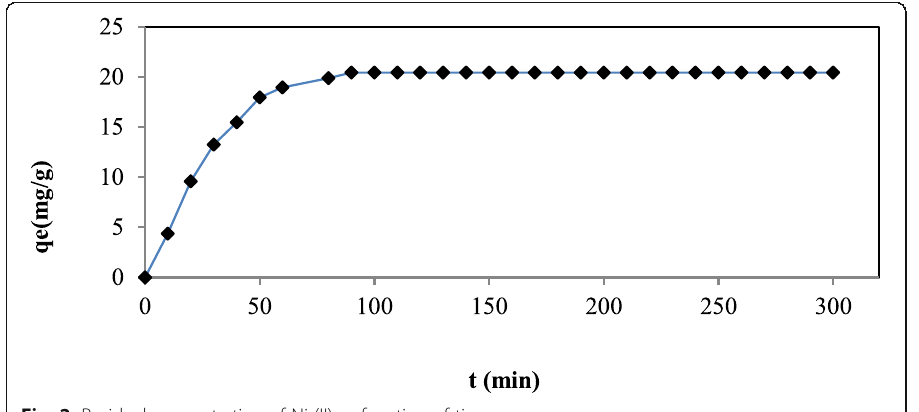
Fig. 2. Residual concentration of Ni (II) as function of time